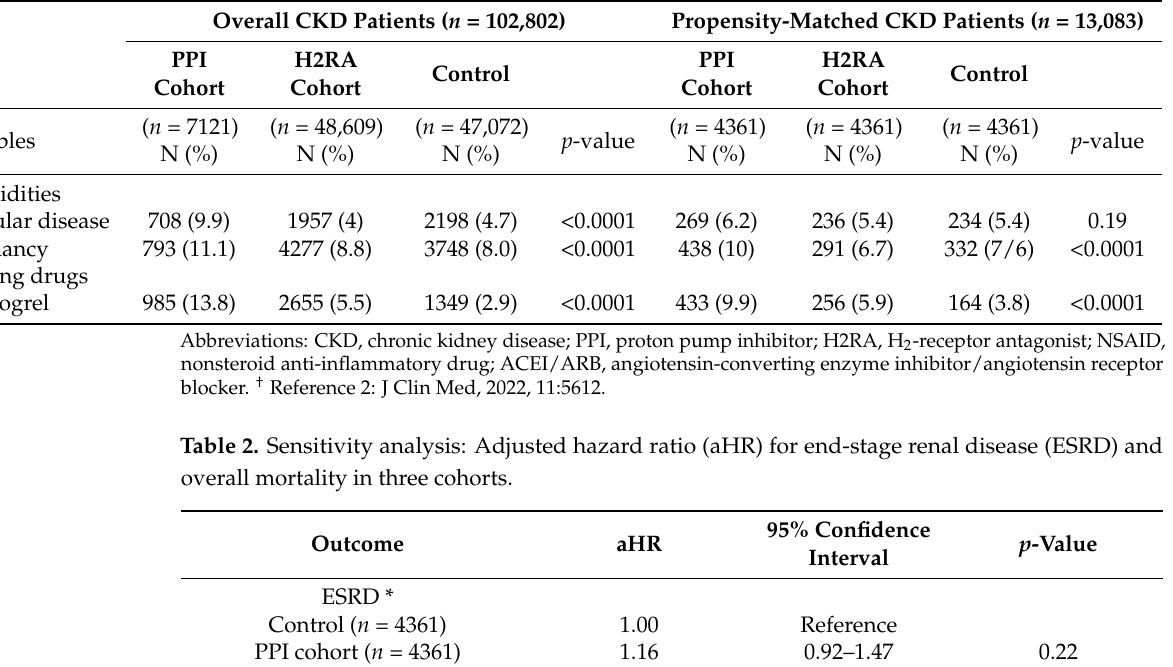
Table 1. Adding two comorbidities and one confounding drug in addition to baseline characteristics shown in the original Table 1 † .